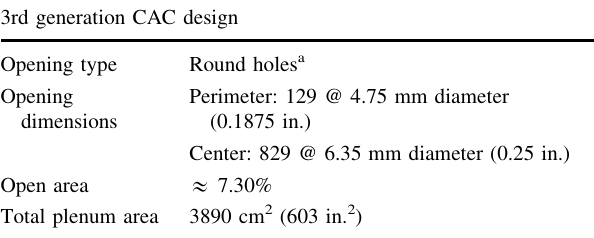
Table 1 Specifications of the plate openings used in Fletcher canopy air